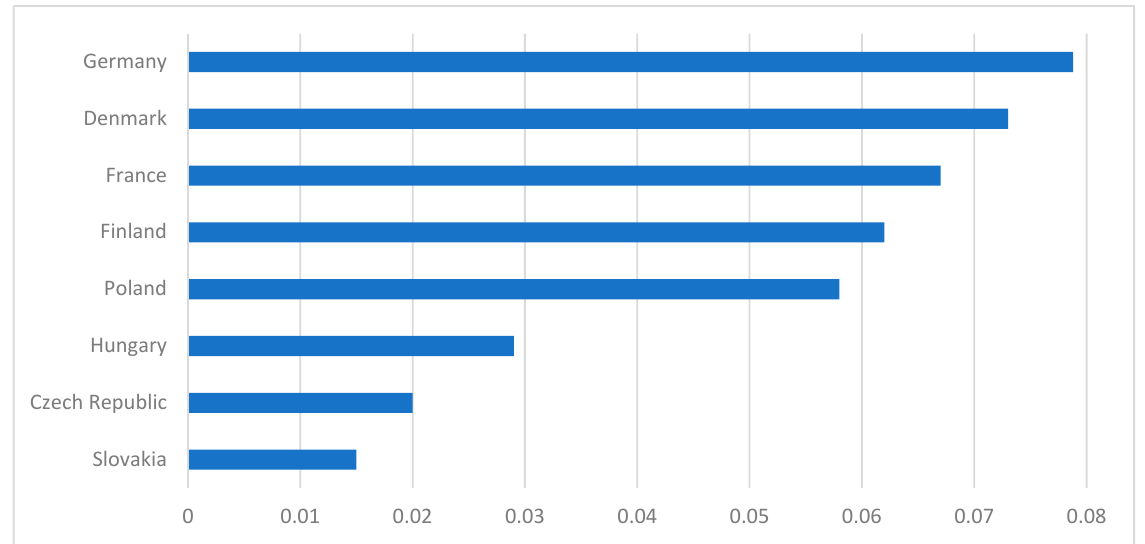
Figure 2. Aggregate bioeconomy efficiency index in the analysed EU countries with different levels of economic development from 2009 to 2018. Source: own elaboration based on Eurostat data [33] and OECD [40].